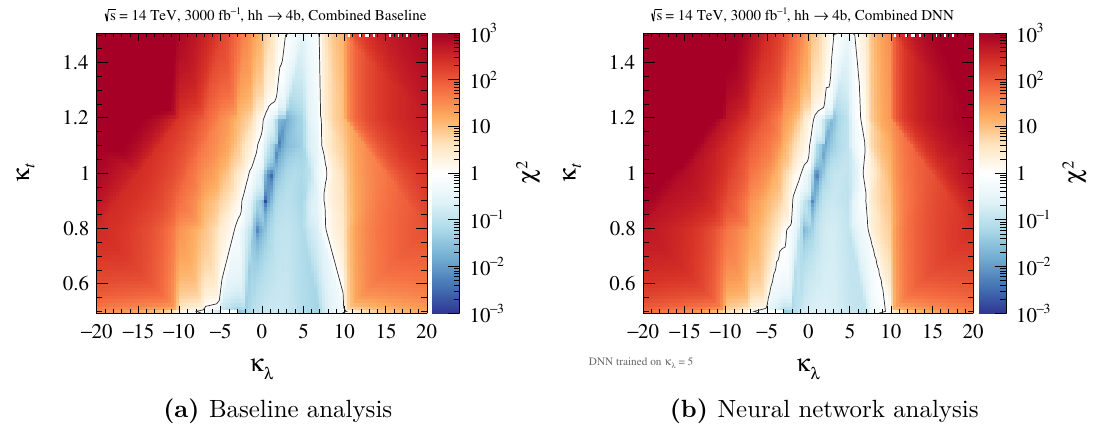
Figure 14. The combined χ 2 distributions for the (a) baseline and (b) neural network analyses in the κ t vs κ λ plane, assuming L = 3000 fb − 1 . The χ 2 statistically combines the resolved, intermediate and boosted categories with 0.3%, 1% and 5% background systematic uncertainties, respectively. The DNN is trained on κ λ = 5 . The grey contour indicates χ 2 = 1 corresponding to 68% CL. A breakdown by analysis category is displayed in appendix